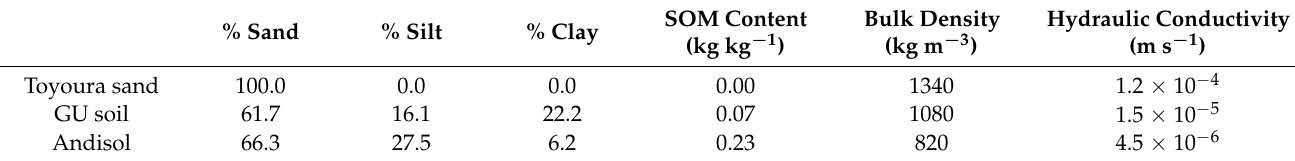
Table 1. Sand, silt, and clay percentages, soil organic matter (SOM) content, bulk density, and hydraulic conductivity of Toyoura sand, soil collected from the Gifu University experimental field (GU soil), and